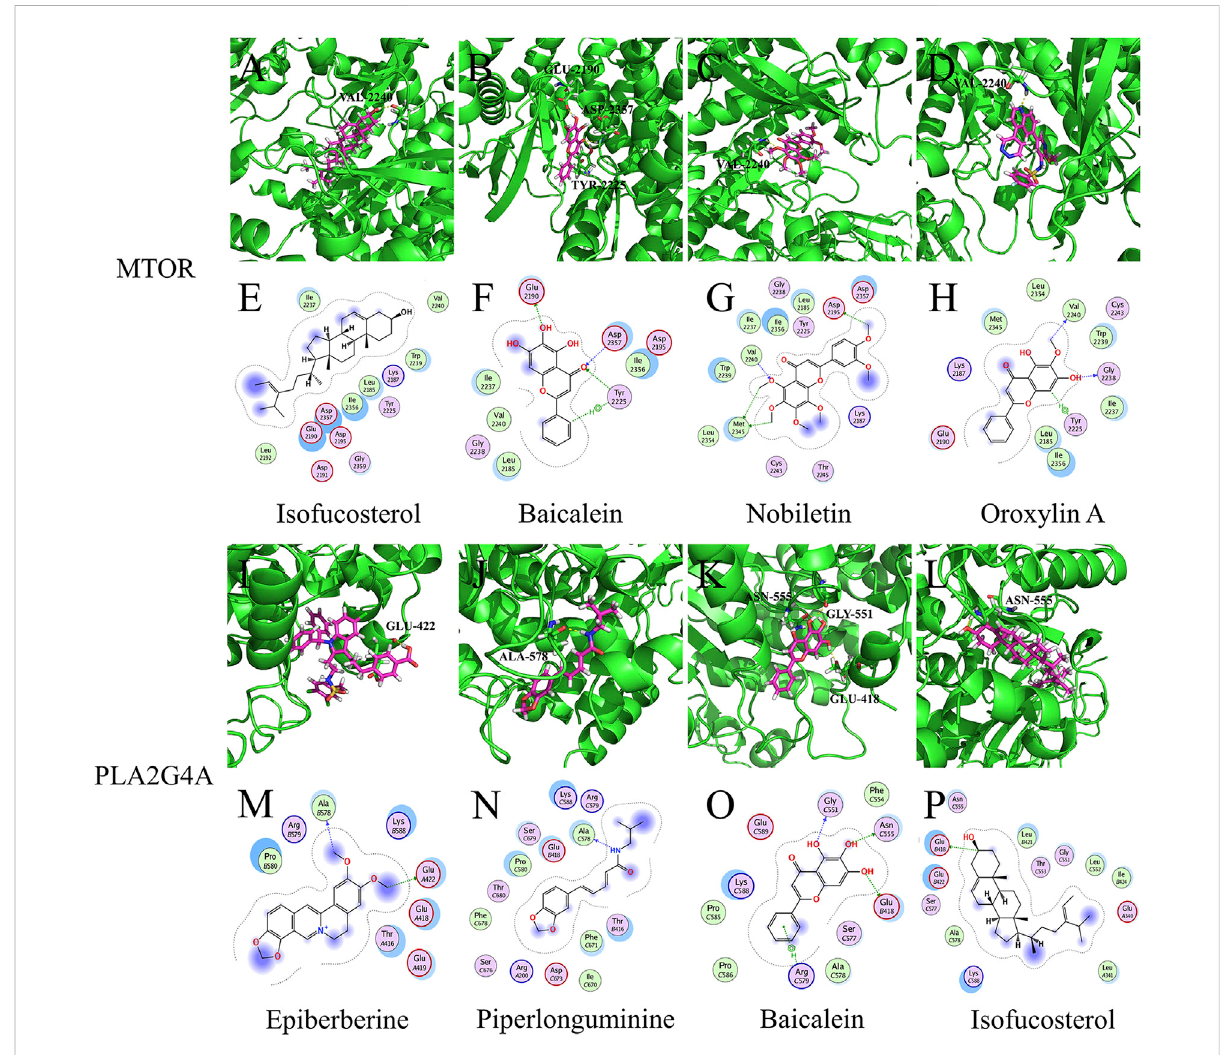
FIGURE 6 Molecular models of active compounds with speci fi c QFPD target genes. (A) Molecular model of isofucosterol binding to mTOR. (B) Molecular modelofbaicalein, (C) nobiletin, (D) oroxylinA, (I) epiberberine, (G) piperlonguminine, (K) baicalein, (L) andisofucosterolbindingtoPLA2G4A.Yellow dashed lines represent H-bonds, thick pink sticks represent active compounds, and thick green sticks represent residues at the protein-binding site. (E) Interaction of isofucosterol, (F) baicalein, (G) nobiletin, and mTOR. (H) Interaction of oroxylin A, (M) epiberberine, (N) piperlonguminine, (O) baicalein, (P) isofucosterol, and PLA2G4A. Blue dashed lines represent H-bonds between the active compounds and residue backbones, and the green dashed lines indicate H-bonds between the active compounds and residue sidechains. The dashed lines point to the acceptor.